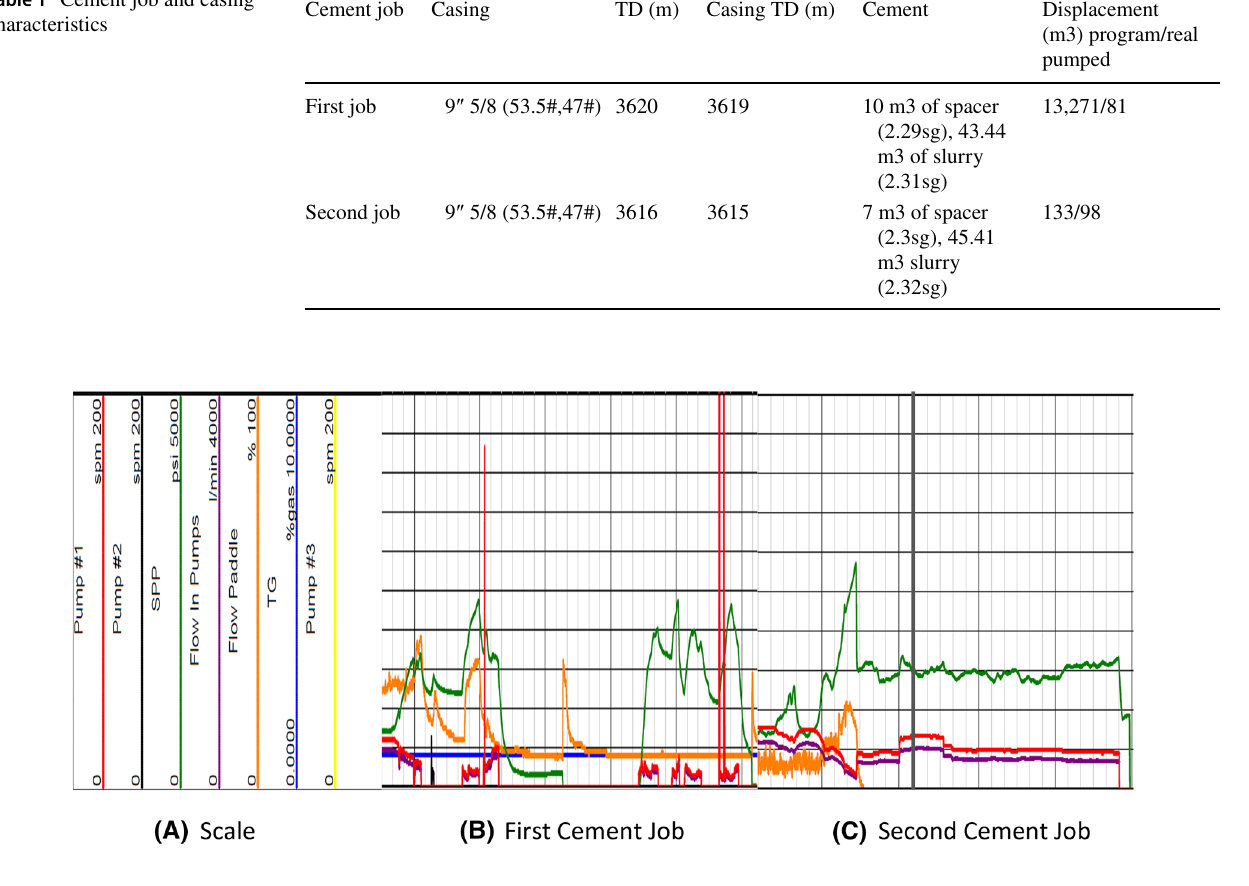
Fig. 1 9 ″ 5/8 displacement chart for the first cement job B and the second